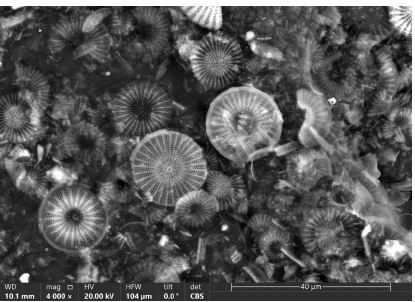
Figure 2. SEM (scanning electron microscopy) image of diatomite.